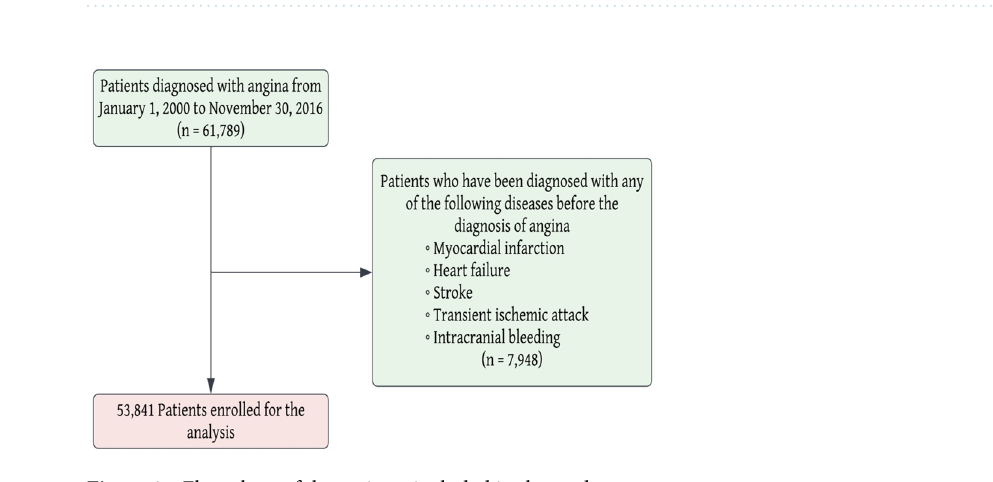
Figure 2. Flow chart of the patients included in the